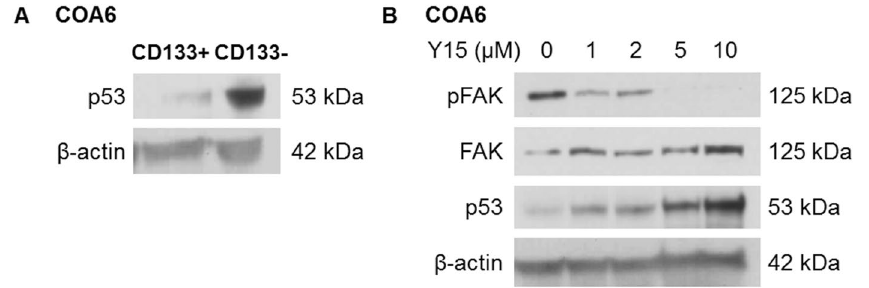
Figure 9. p53 expression in neuroblastoma PDX SCLCC. ( A ) Immunoblotting for p53 of CD133 sorted COA6 cell lysates revealed decreased expression of p53 in the CD133-enriched (CD133 + ) compared to the CD133-depleted (CD133 − ) cell population. ( B ) COA6 unsorted tumor cells were treated with increasing concentrations of PF for 24 hours. Whole cell lysates were subjected gel electrophoresis and immunoblotting completed for p53. Expression of p53 increased as pFAK expression decreased. Expression of β -actin confirmed equal protein